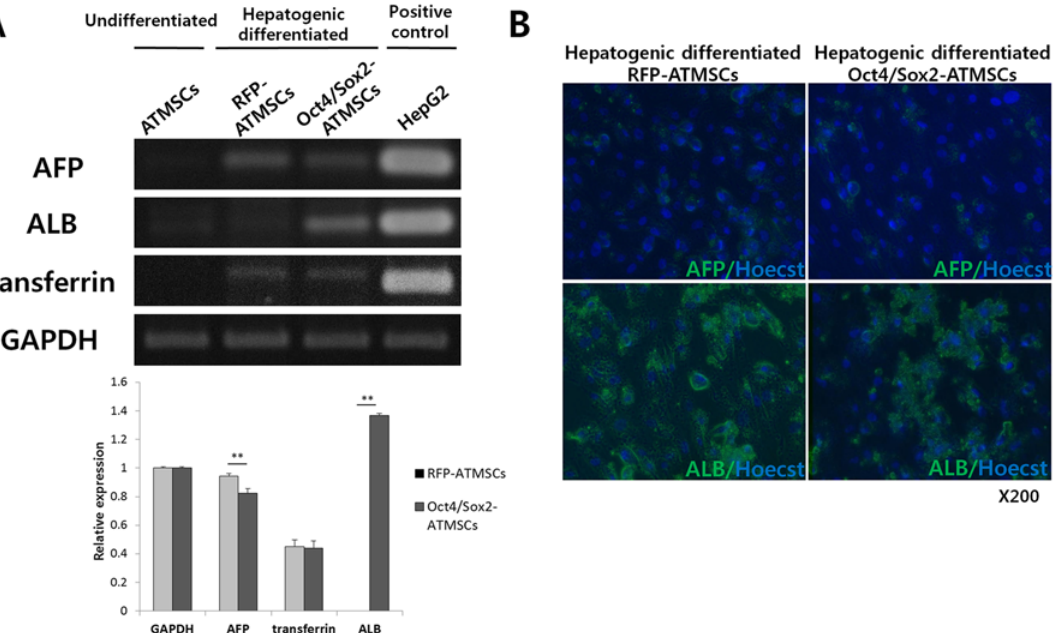
Fig 4. PCR analysis and immunofluorescence of liver markers after 28 days hepatogenic differentiation. (A) The mRNA expression level of albumin (ALB) was strongly expressed in hepatogenically differentiated Oct4/Sox2-ATMSCs, whereas the expression level of α -fetoprotein (AFP) was lower than that of RFP-ATMSCs. The expression levels of transferrin were not significantly different in both cells. Undifferentiated ATMSCs and HepG2 were used as negative and positive controls, respectively. (B) Hepatocyte-like cells from RFP- and Oct4/Sox2-ATMSCs are confirmed by immunofluorescence staining for AFP and ALB. Nuclei were counterstained with